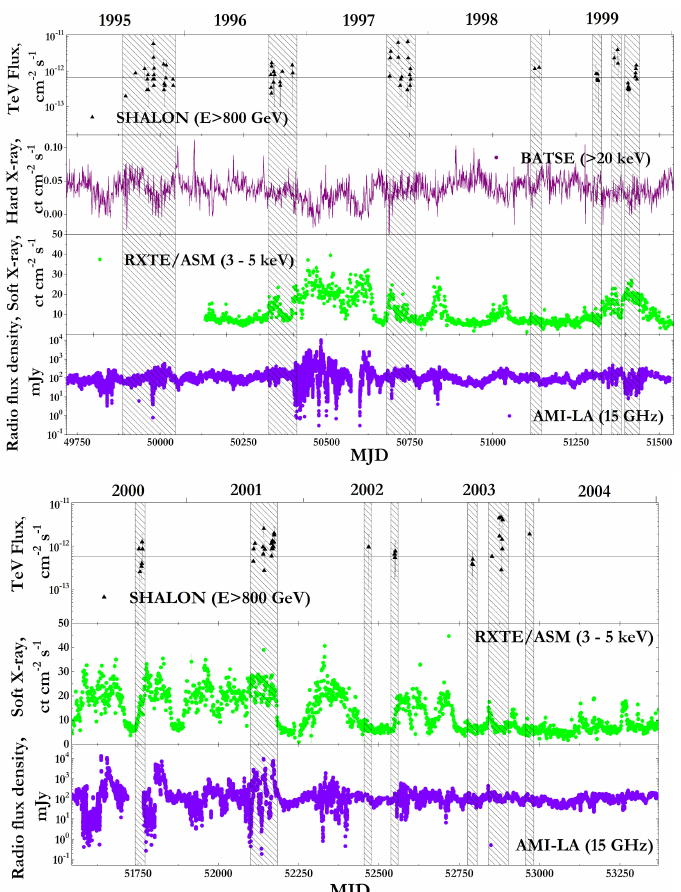
Figure 5. Light curve of Cyg X-3 in a wide energy range: radio 15 GHz (RT/AMI), soft X-rays at 3–5 keV (RXTE/ASM), hard X-rays at 20–2000 keV (BATSE), and very high energies 800 GeV–100 TeV (SHALON). The data over the period 1995–2004 are